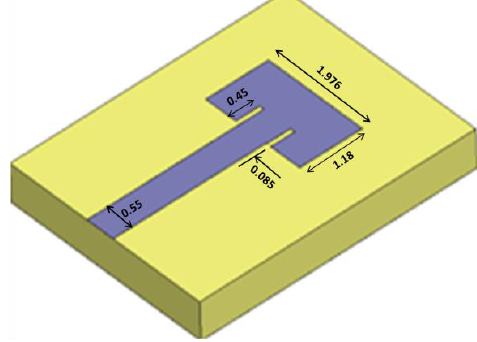
Figure 12: Geometry of the patch antenna Table-IX: Computed Antenna